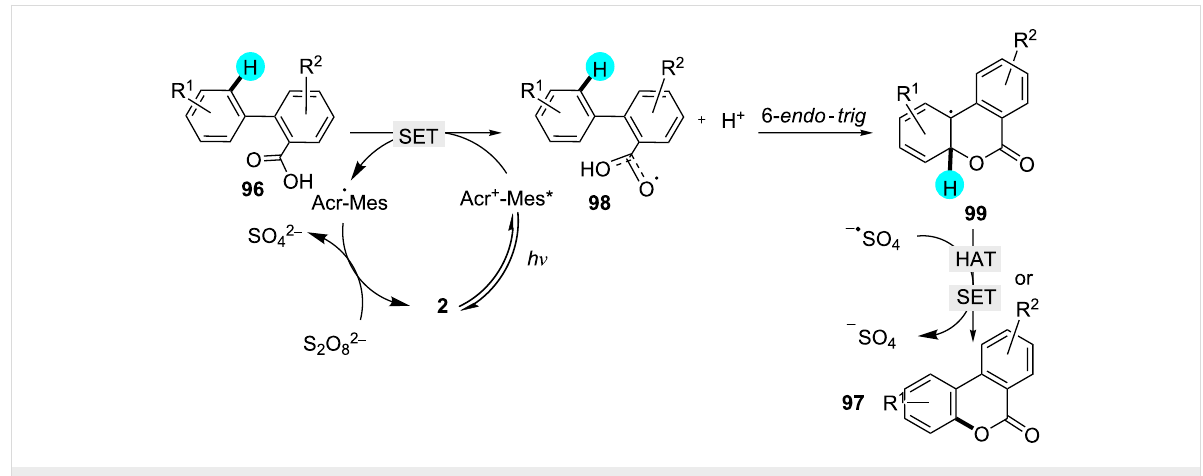
Figure 15: Plausible mechanism for the synthesis of substituted coumarins.